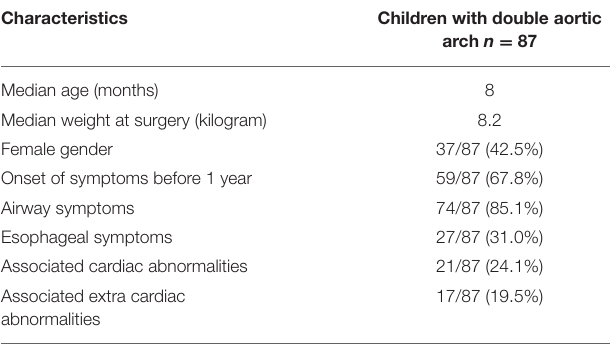
TABLE 3 | Recurrence of symptoms and